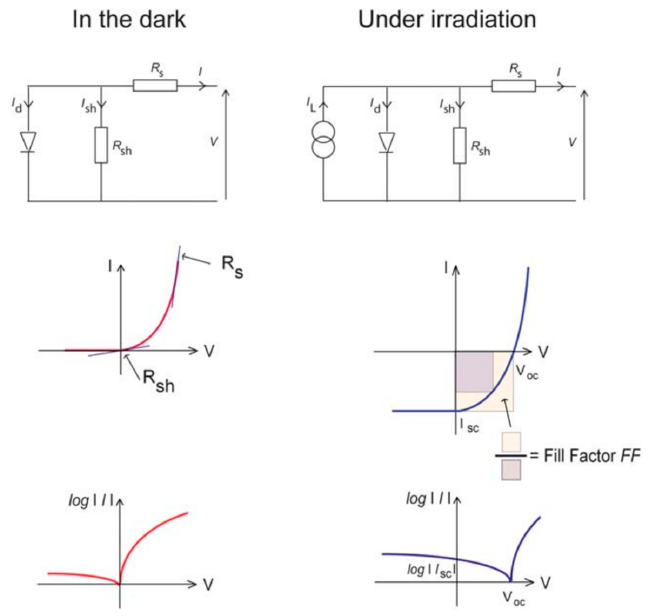
Figure 4. Equivalent circuit diagrams and current-voltage characteristics (in linear and semi- logarithmic scales) for hybrid solar cells in the dark and under irradiation. The definition of fill factor is also shown, as the area of the orange square divided by the area of the purple square. The fill factor, along with V oc and I sc , describes the maximum power from the solar cell. Reproduced from [37] with permission of the Royal Society of